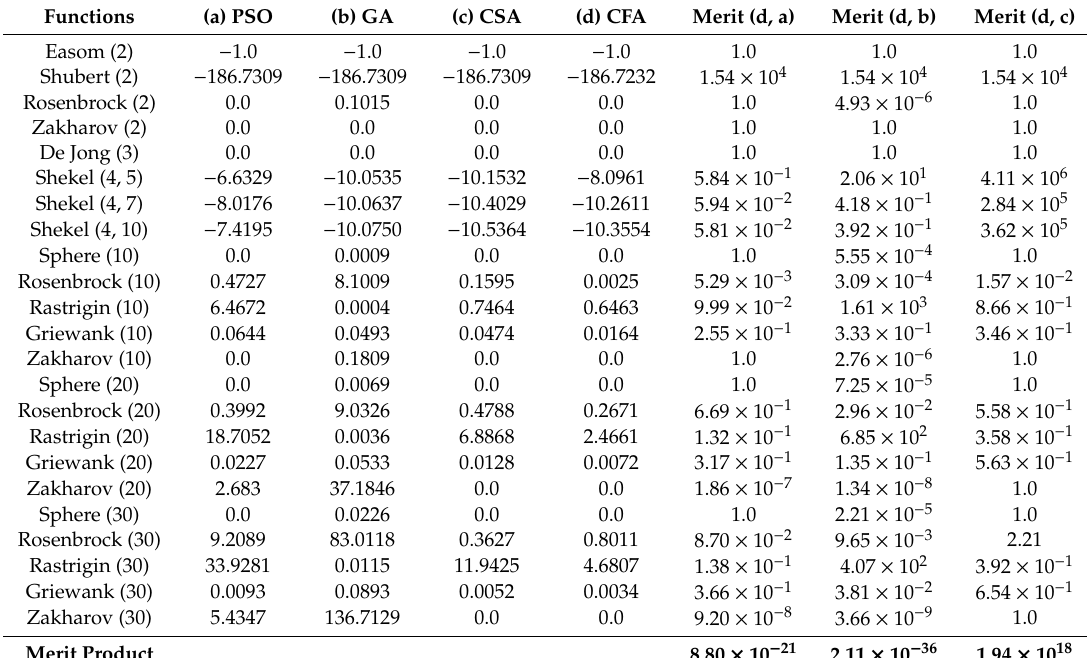
Table 8. The performance comparison between the CFA and other metaheuristics.